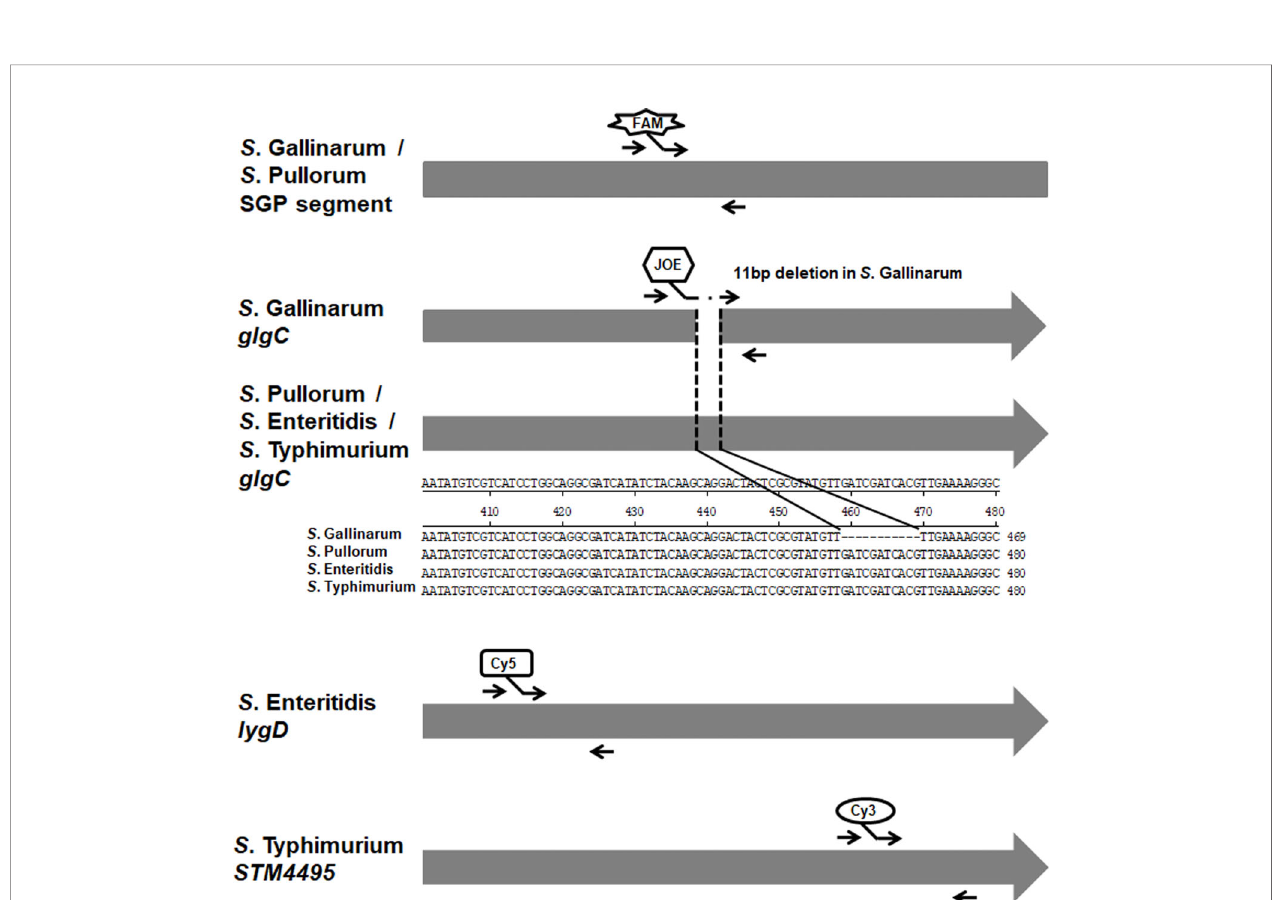
FIGURE 1 | Diagram of the primers and probes designing for the multiplex real-time PCR. The speci fi c gene or segment of these four Salmonella serovars was analyzed and exploited to design the primers and probes. The primers and fl uorophore-labeled probes were indicated. The arrows indicated the positions of the designed primers. In addition, the alignments of glgC genes in S . Gallinarum, S . Pullorum, S . Enteritidis, and S. Typhimurium were